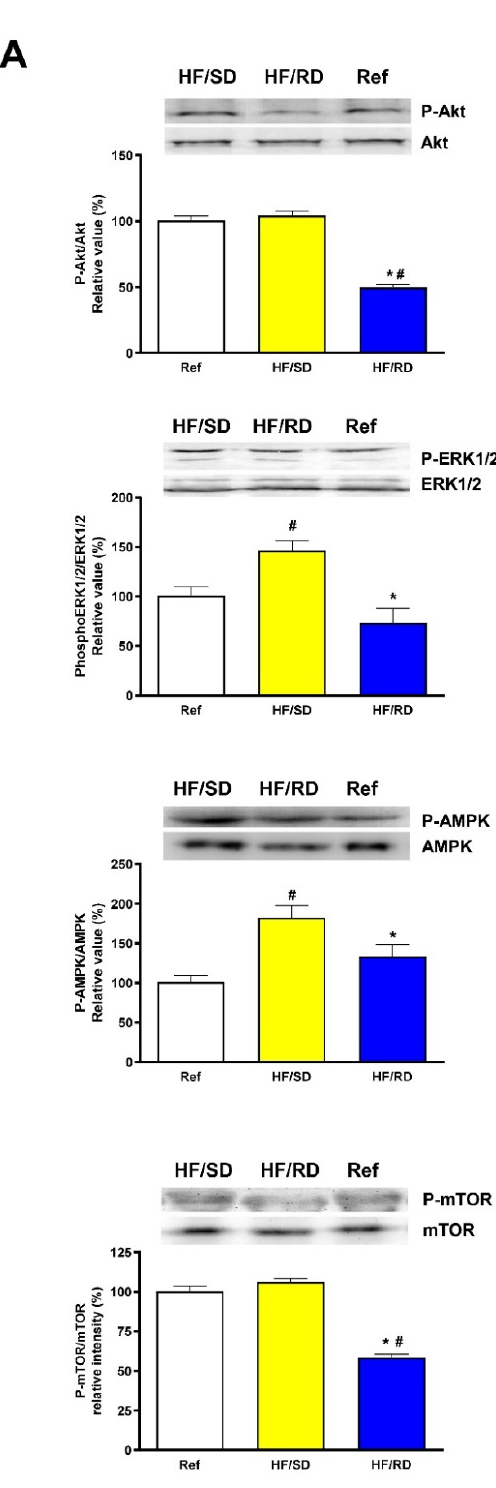
Figure 5. Modulation of muscle offspring signaling pathways by maternal diets. Phosphorylative status of Akt, ERK1/2, AMPK and mTOR was measured by Western blot in gastrocnemius muscle at weaning ( W ) and adolescence ( A ). Values are means ± SEM ( n = 8 for each experimental group). HF/SD: offspring from mothers on high-fat diet containing slow digesting carbohydrates; HF/RD: offspring from mothers on high-fat diet containing rapid digesting carbohydrates; Ref: offspring from mothers on AIN93G diet. * Significant difference with HF/SD group, p < 0.05. # Significant difference with reference group, p < 0.05.